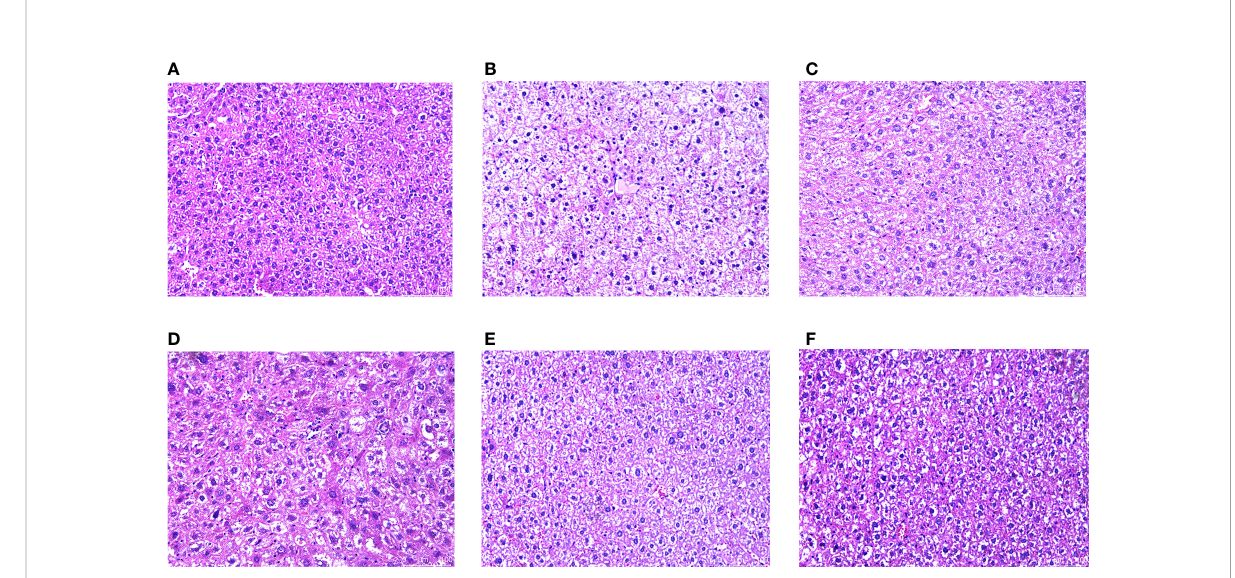
FIGURE 5 Effect of CRPR on liver histopathology. Representative H&E staining of liver sections from the (A) NC, (B) MC, (C) MET, (D) CRPR-L, (E) CRPR-M, and (F) CRPR-H groups (200x magni fi